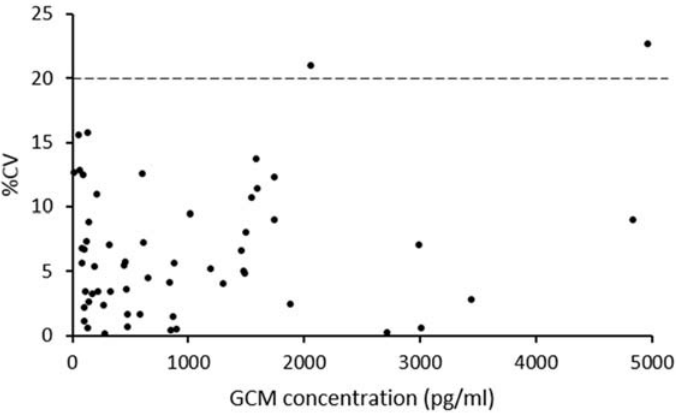
Figure 2. Global precision profile established from the measurements of samples used during the procedure selection and analytical validation of the CCC EIA kit ( n = 57) showing the obtained intra ‐ assay %CV in function of the GCM concentrations in the EIA wells (pg/mL). The dotted line stands for the 20% limit of acceptable CV%.